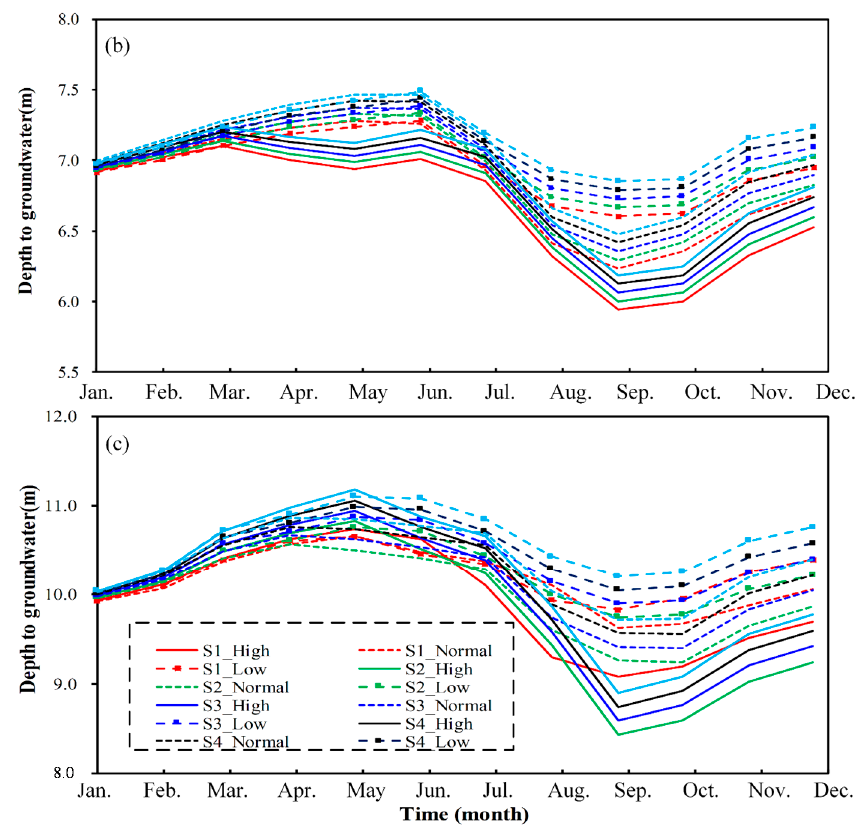
Figure 9. Monthly predicted GWD in 2015 determined by MLR models of five scenarios (( a – c ) represent the results of districts 2, 4 and 9, respectively).